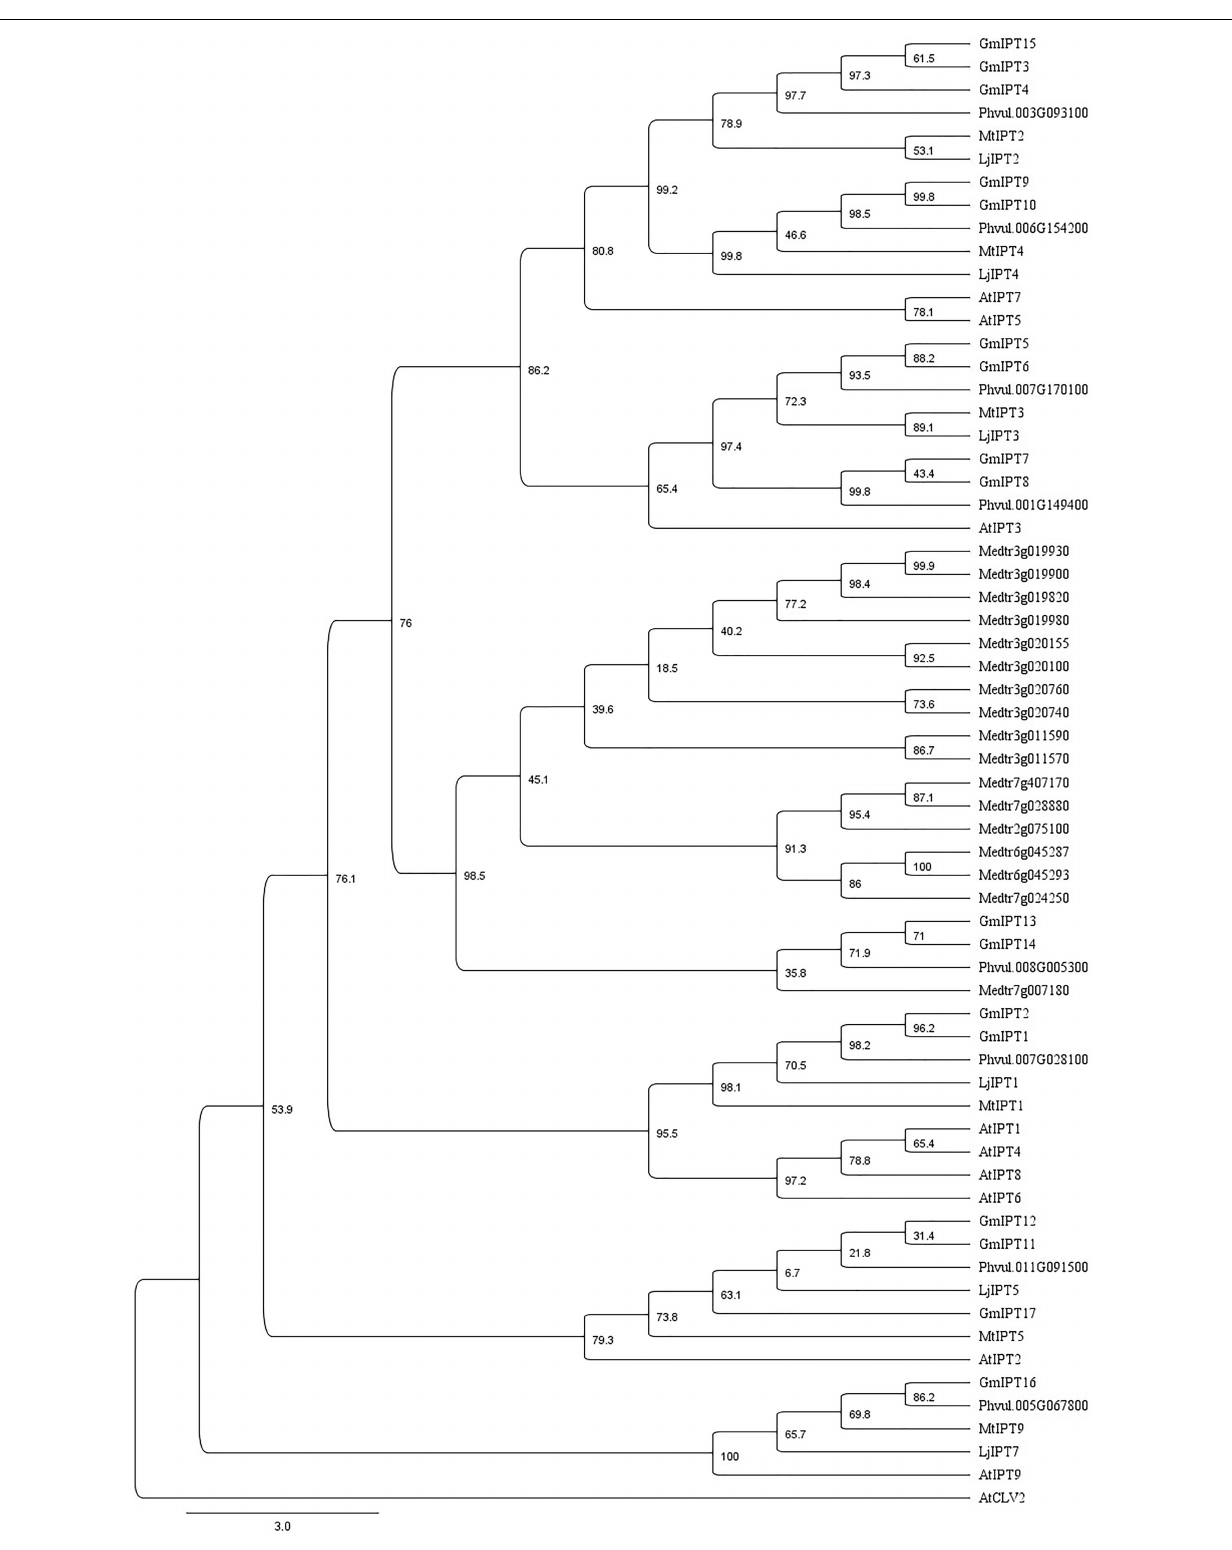
Frontiers in Plant Science |